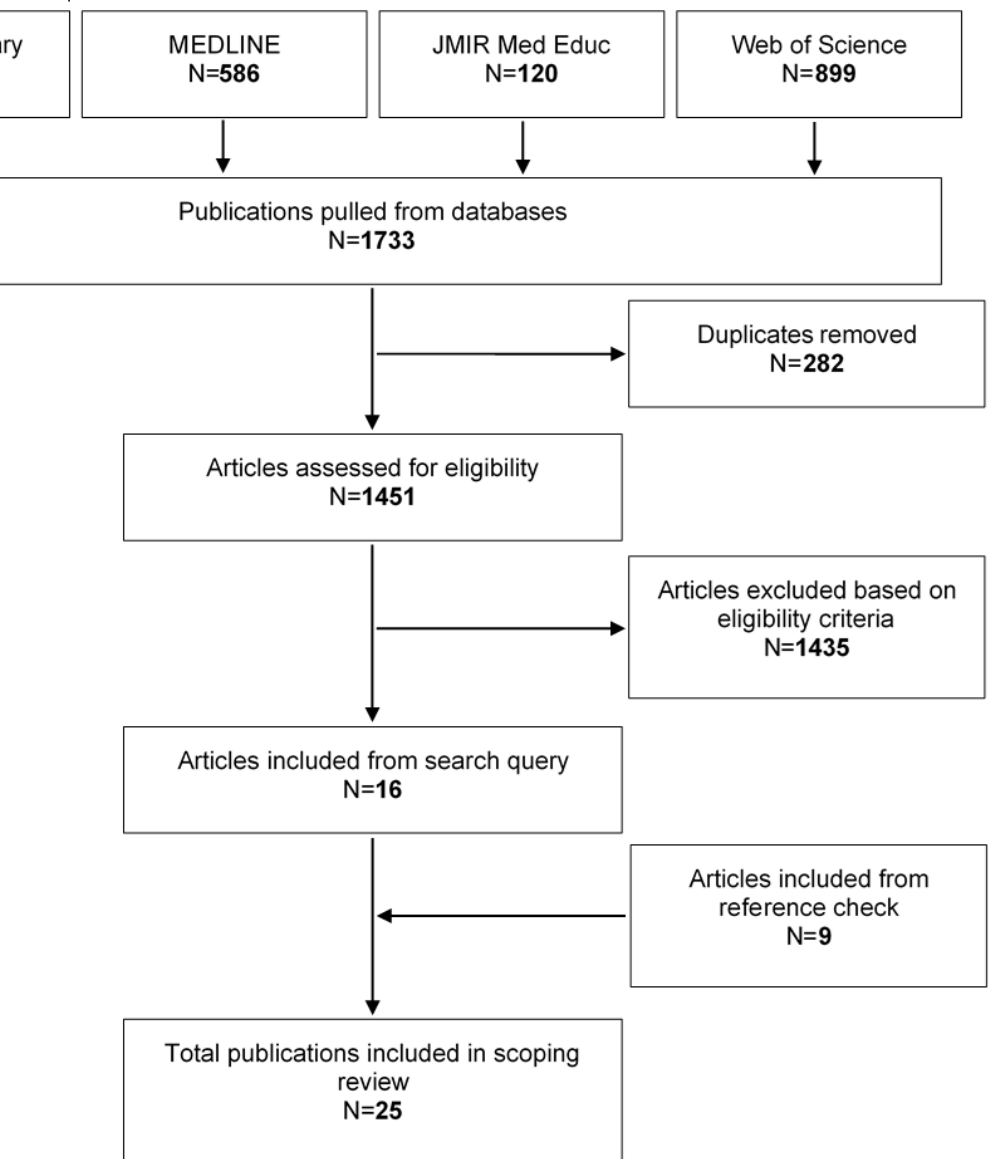
Figure 1. Flowchart of the selection